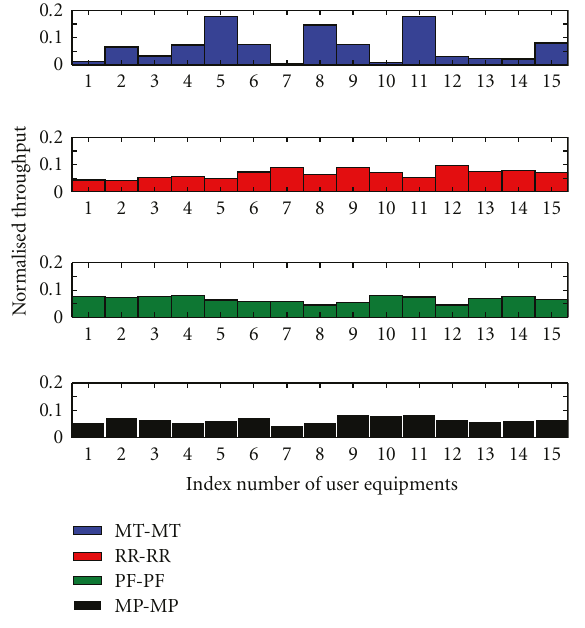
Figure 8: Normalized throughput distribution per UE.